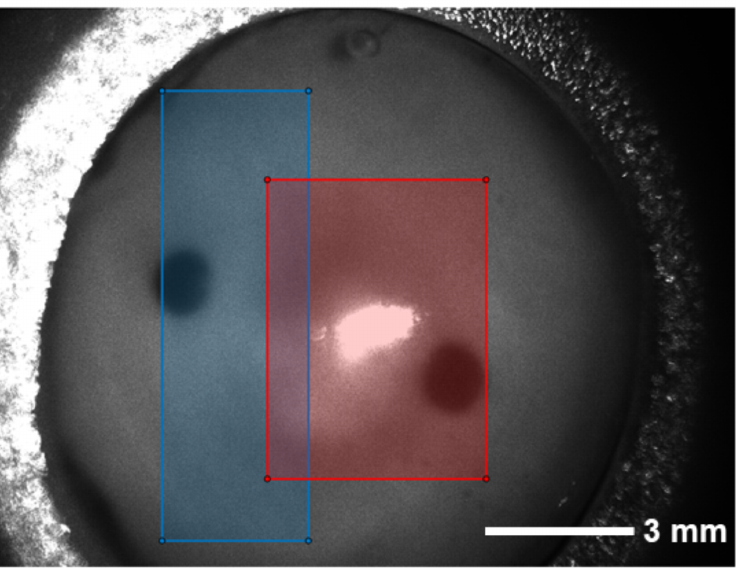
Figure 4. Raw image taken with the polarization state HH for PSG (first letter) and PSA (second letter) as an example. The cornea is mounted on a specific polymer chamber to prevent it drying out which is achieved by the refilling of Dextran 500 solution. The back of the holder can also be seen as the cornea is transparent. In the central part, it becomes obvious that a region of the image is overexposed which needs to be excluded from later analysis. The black, nearly circular areas in the image show the liquid access to the chamber. The two boxes indicate from which areas of the images the used measurement data are. The blue area consists of the cornea without the reflection while the red area also contains the reflection